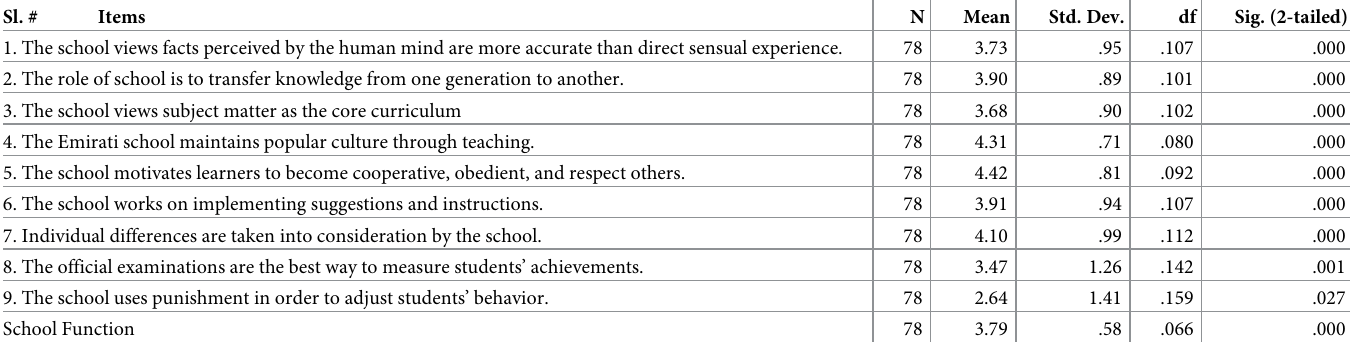
Table 6. One-sample statistics (school function and related items, test value = 3). Sl. #